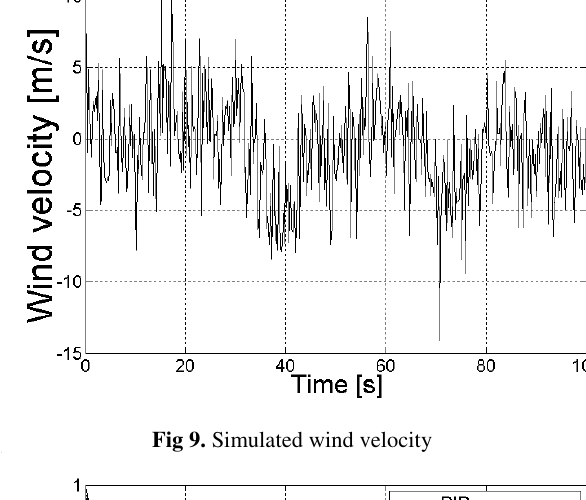
Fig 10d. Influence of turbulence with the use of control law (13)